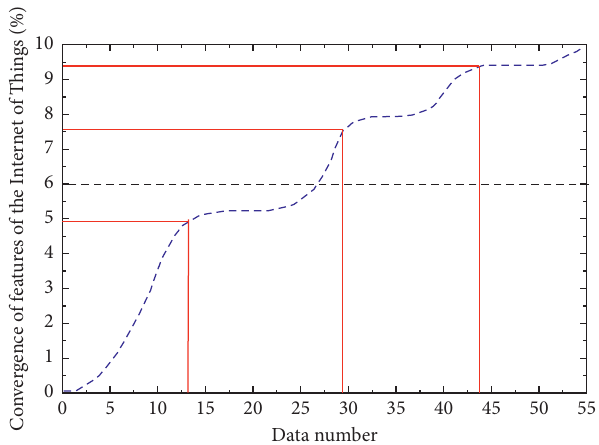
Figure 2: Convergence curve of Internet of Things